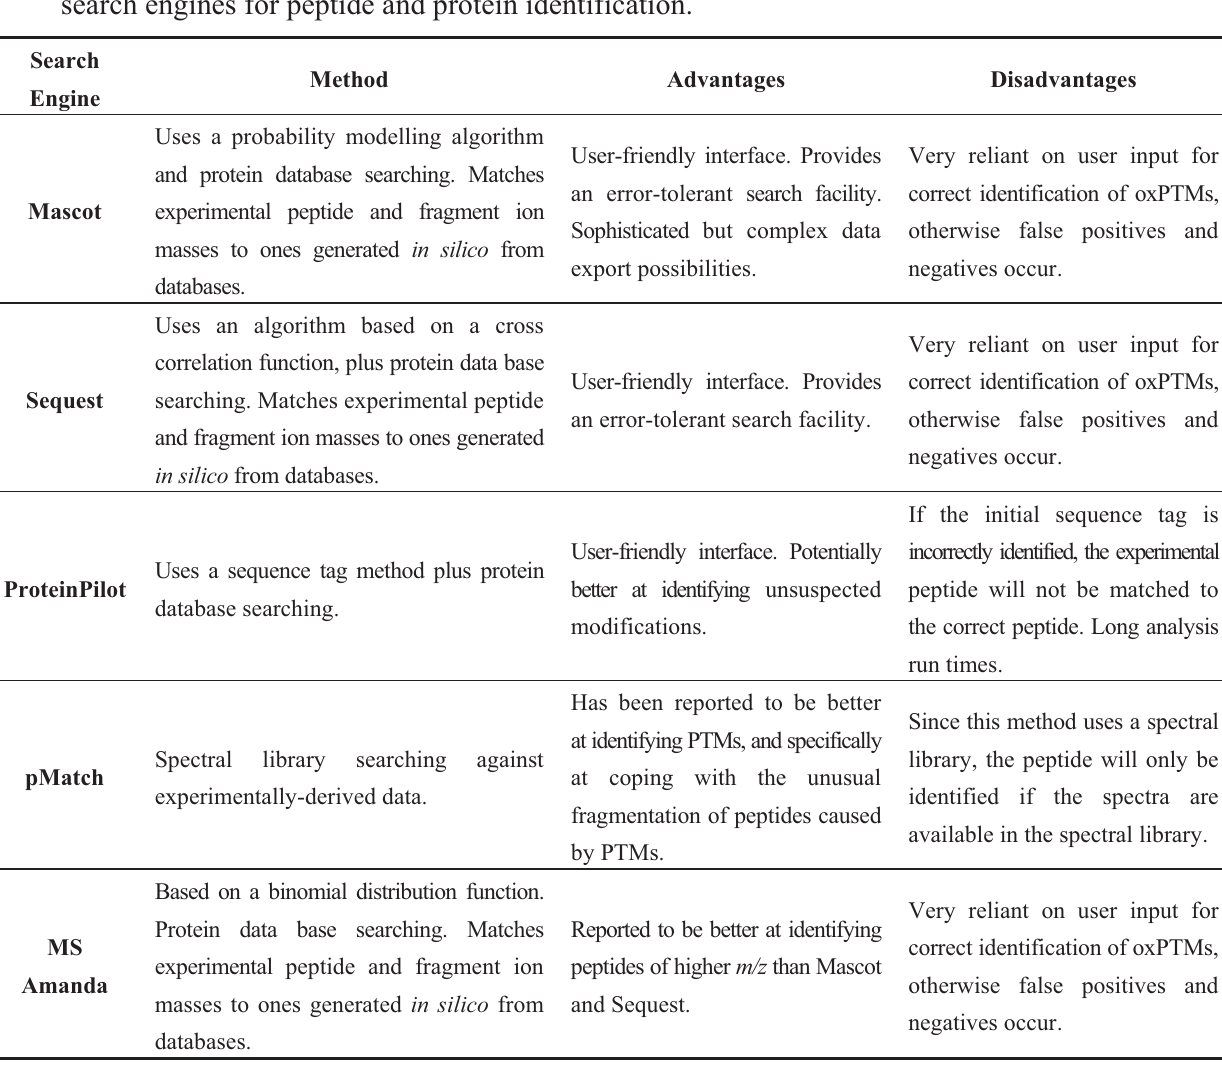
Table 1. Comparison of the advantages and disadvantages of the most commonly used search engines for peptide and protein